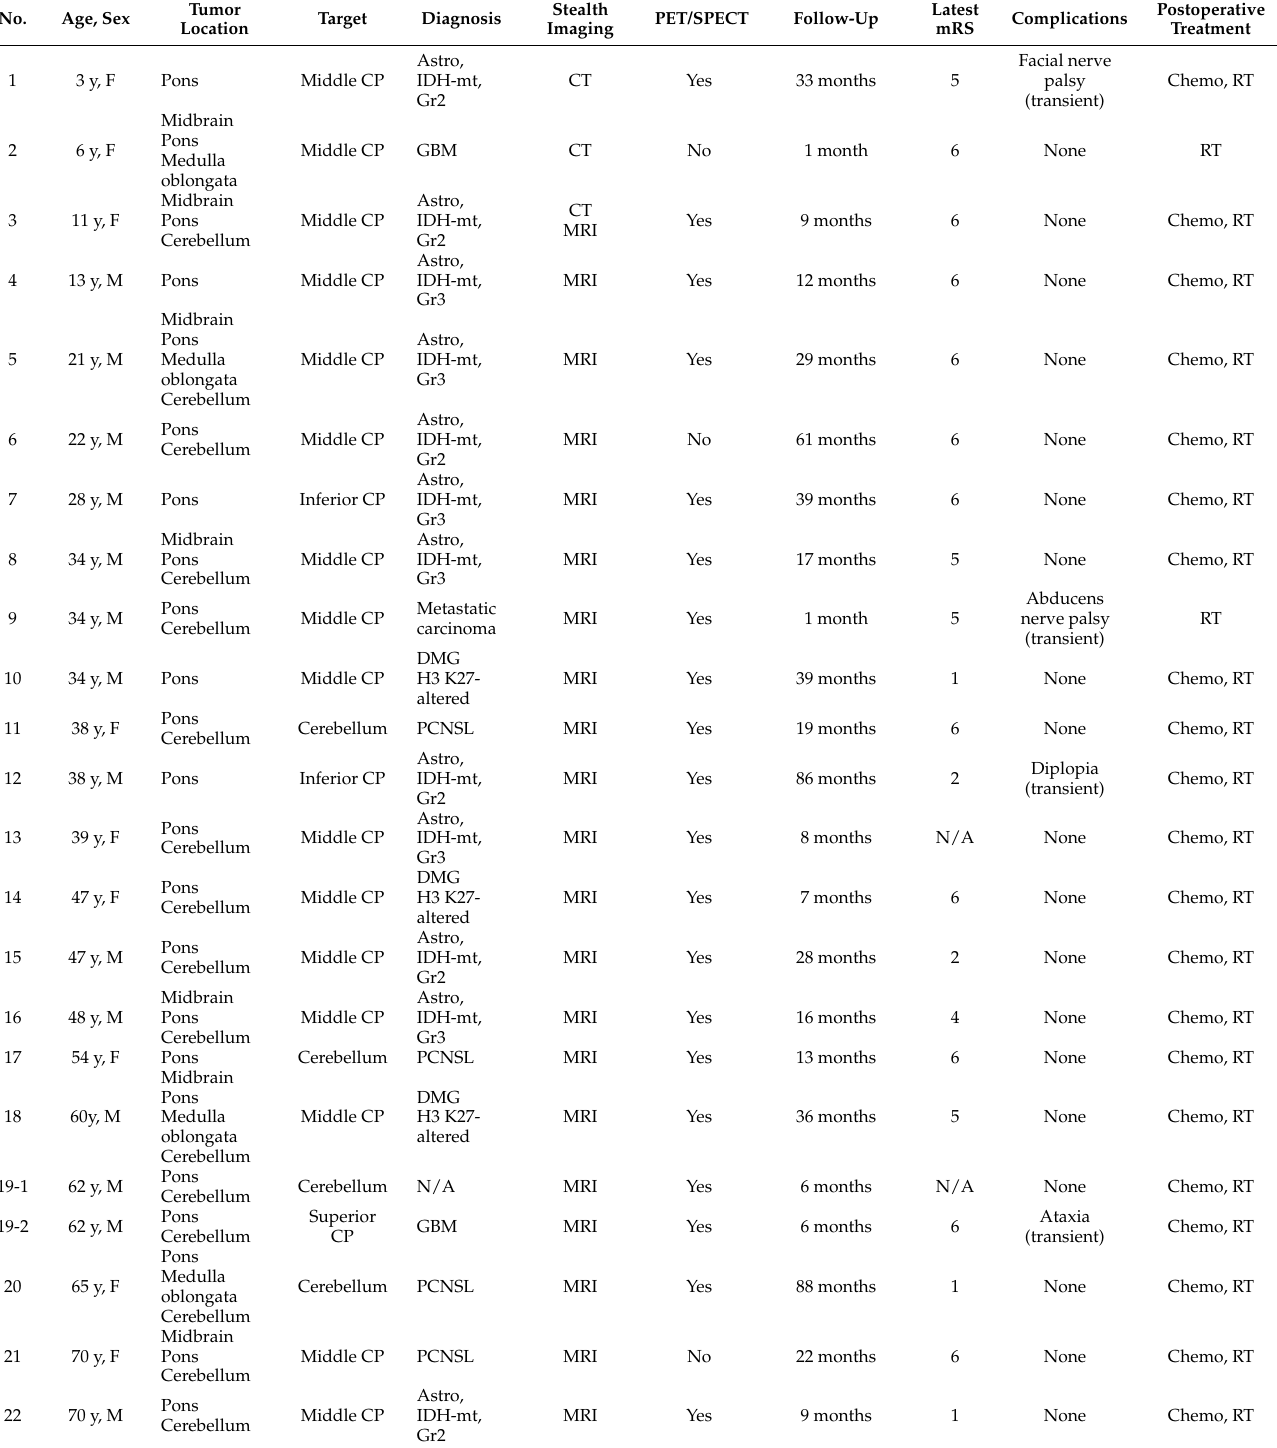
Table 1. Summary of stereotactic tumor biopsies of neoplastic lesions in the